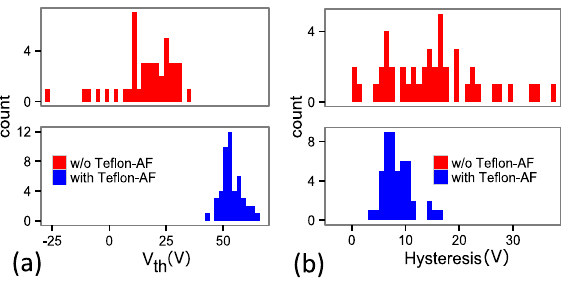
Figure 5. Histogram distribution of ( a ) threshold voltage; ( b ) gate hysteresis of 60 measured devices before and after applying Teflon ‐ AF cap.